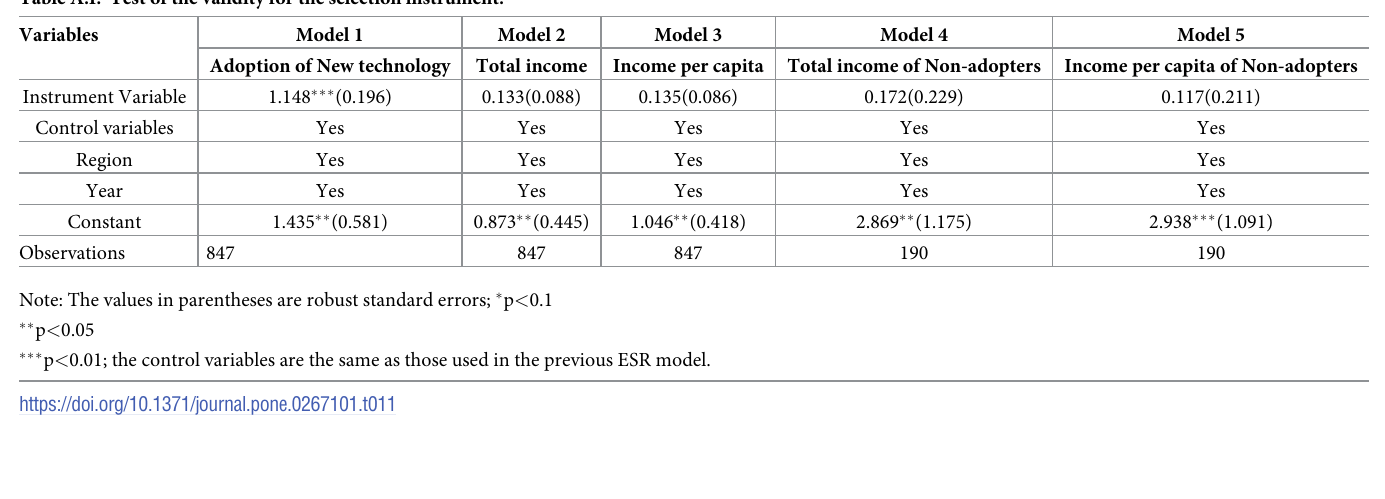
Table A.I. Test of the validity for the selection